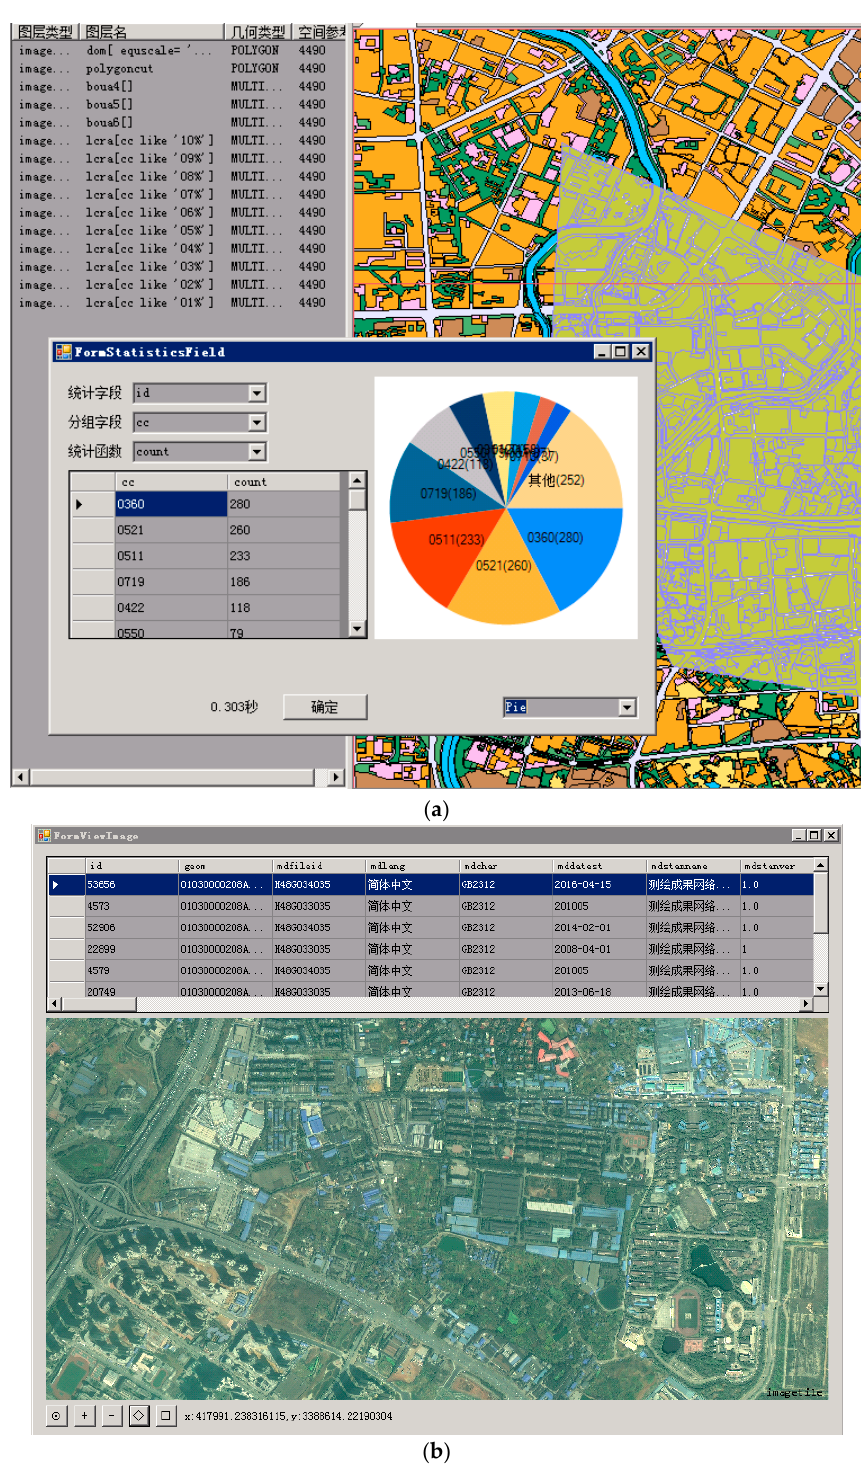
Figure 12. Desktop used for clips, statistics, and query data on the data cluster. ( a ) Spatial analysis and statistics of distributed massive vector data. There are many spatial analysis and statistical functions that can be used. These operations can also interact with each other for a more sophisticated analysis. ( b ) Query and management of distributed massive image data. Through the data cluster and file server, the images can be managed and queried in an integrated manner; in addition, the image entity files are not put into the database, and the original image directory does not need to be modified, and can be used directly.